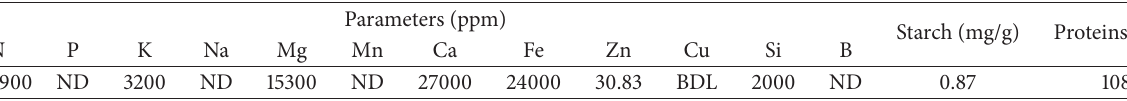
(b) Minerals, starch, and protein quantification of C. dipsaceus leaf